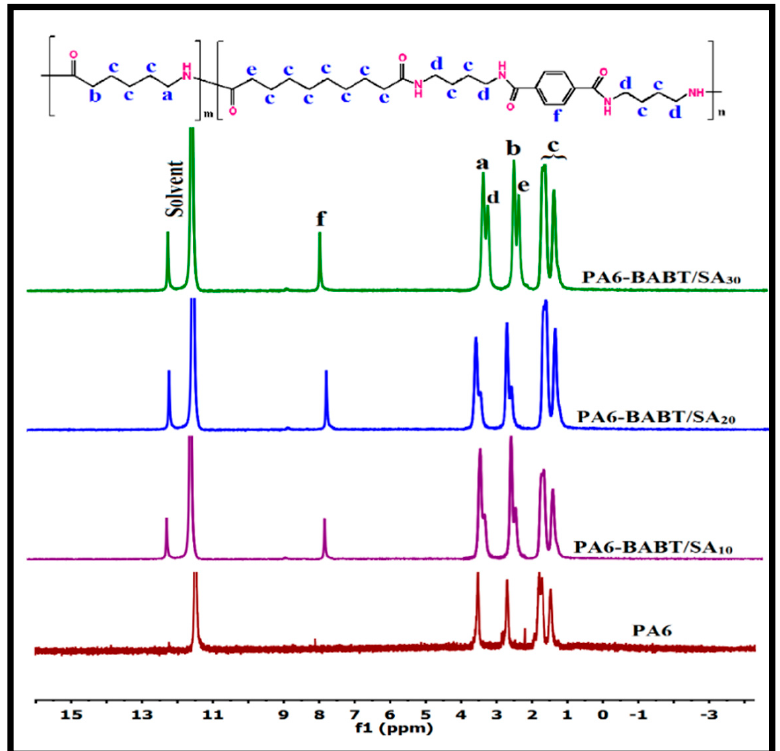
Figure 4. 1 H NMR spectra of PA6 and PA6-BABT/SA copolyamides.